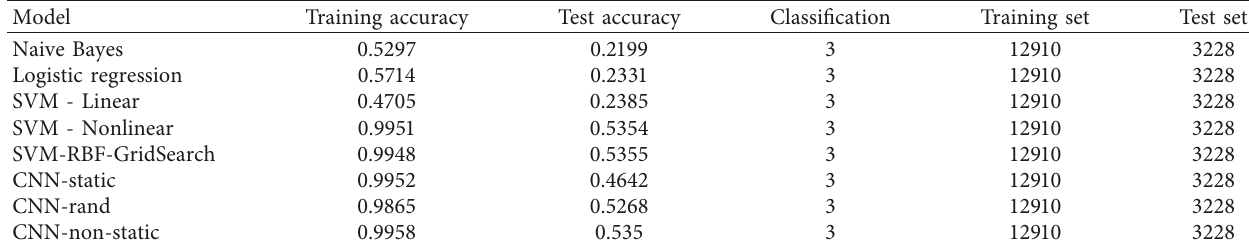
Table 1: Comparison of traditional algorithms and CNN